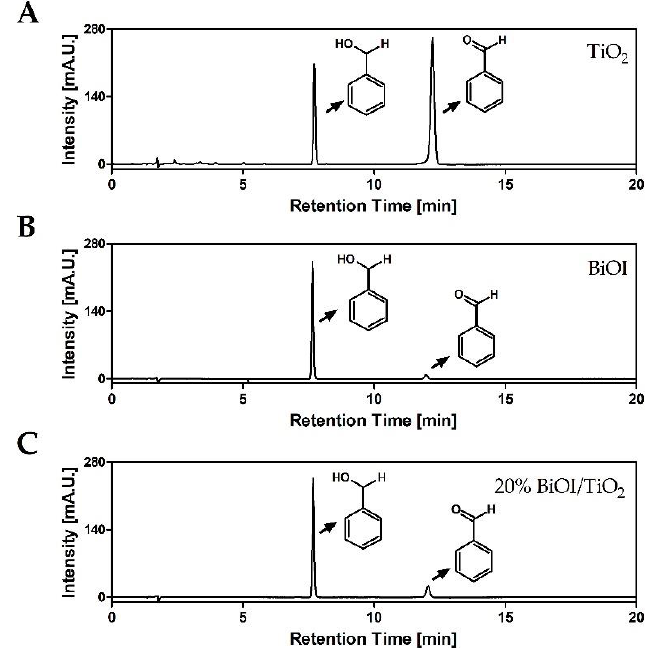
Figure 7. HPLC chromatogram of oxofunctionalizated products of benzyl alcohol. ( A ) Titanium dioxide; ( B ) bismuth oxyiodide; ( C ) 20% BiOI/TiO 2 . Peak 1 (RT = 7.7 min) corresponds to benzyl alcohol and peak 2 (RT = 12.7 min) corresponds to benzaldehyde. Table 3. Selective photocatalytic oxidation of benzyl alcohol over synthesized photocatalysts and others reported